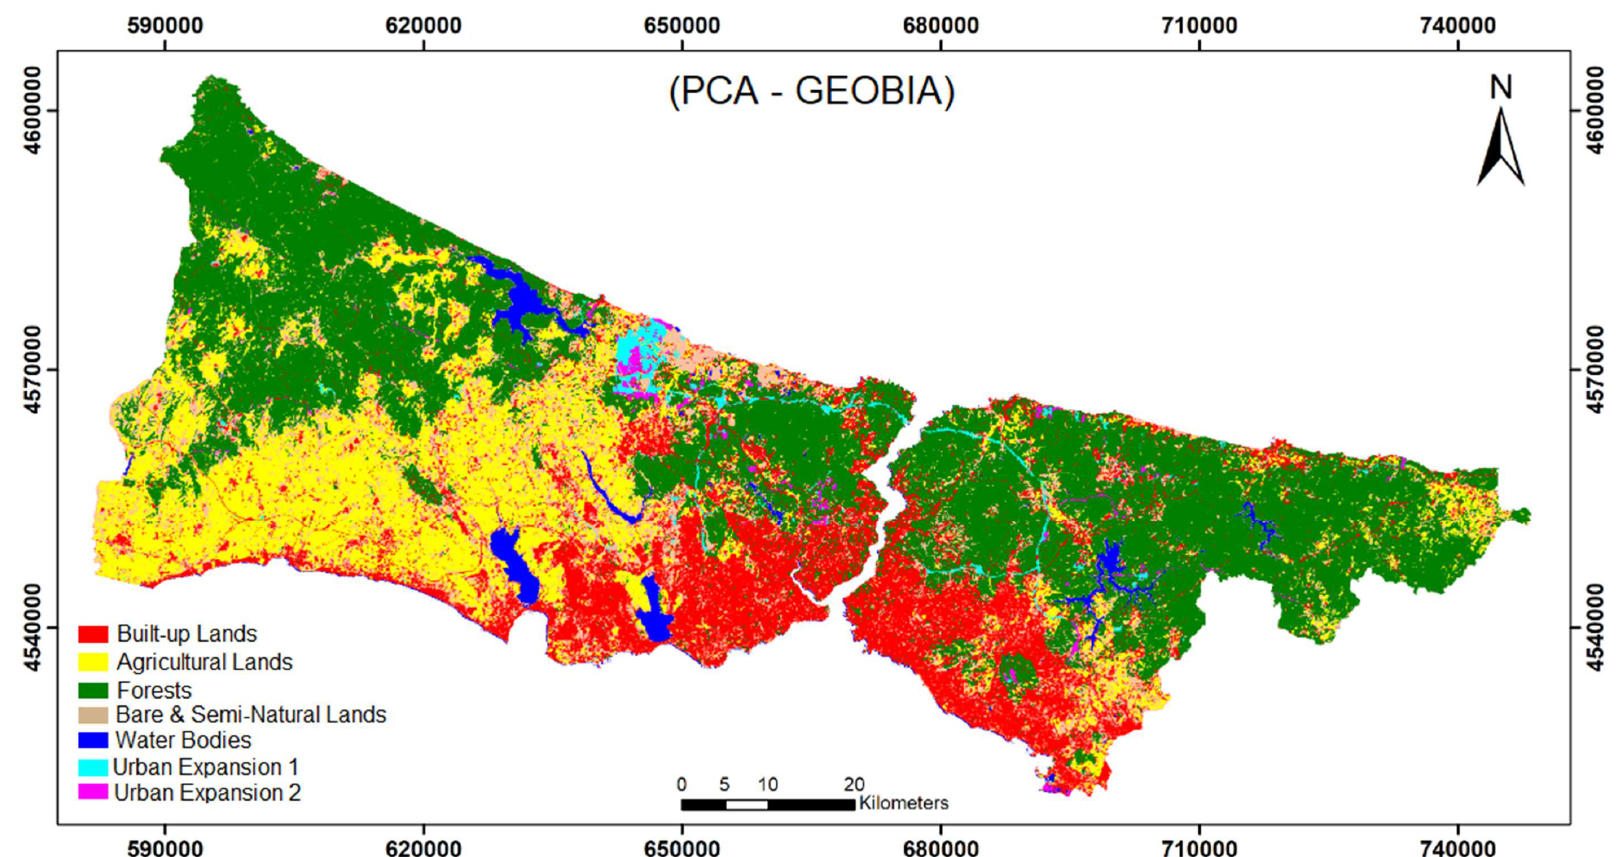
Figure A4. GEOBIA classification results of the PCA dataset.